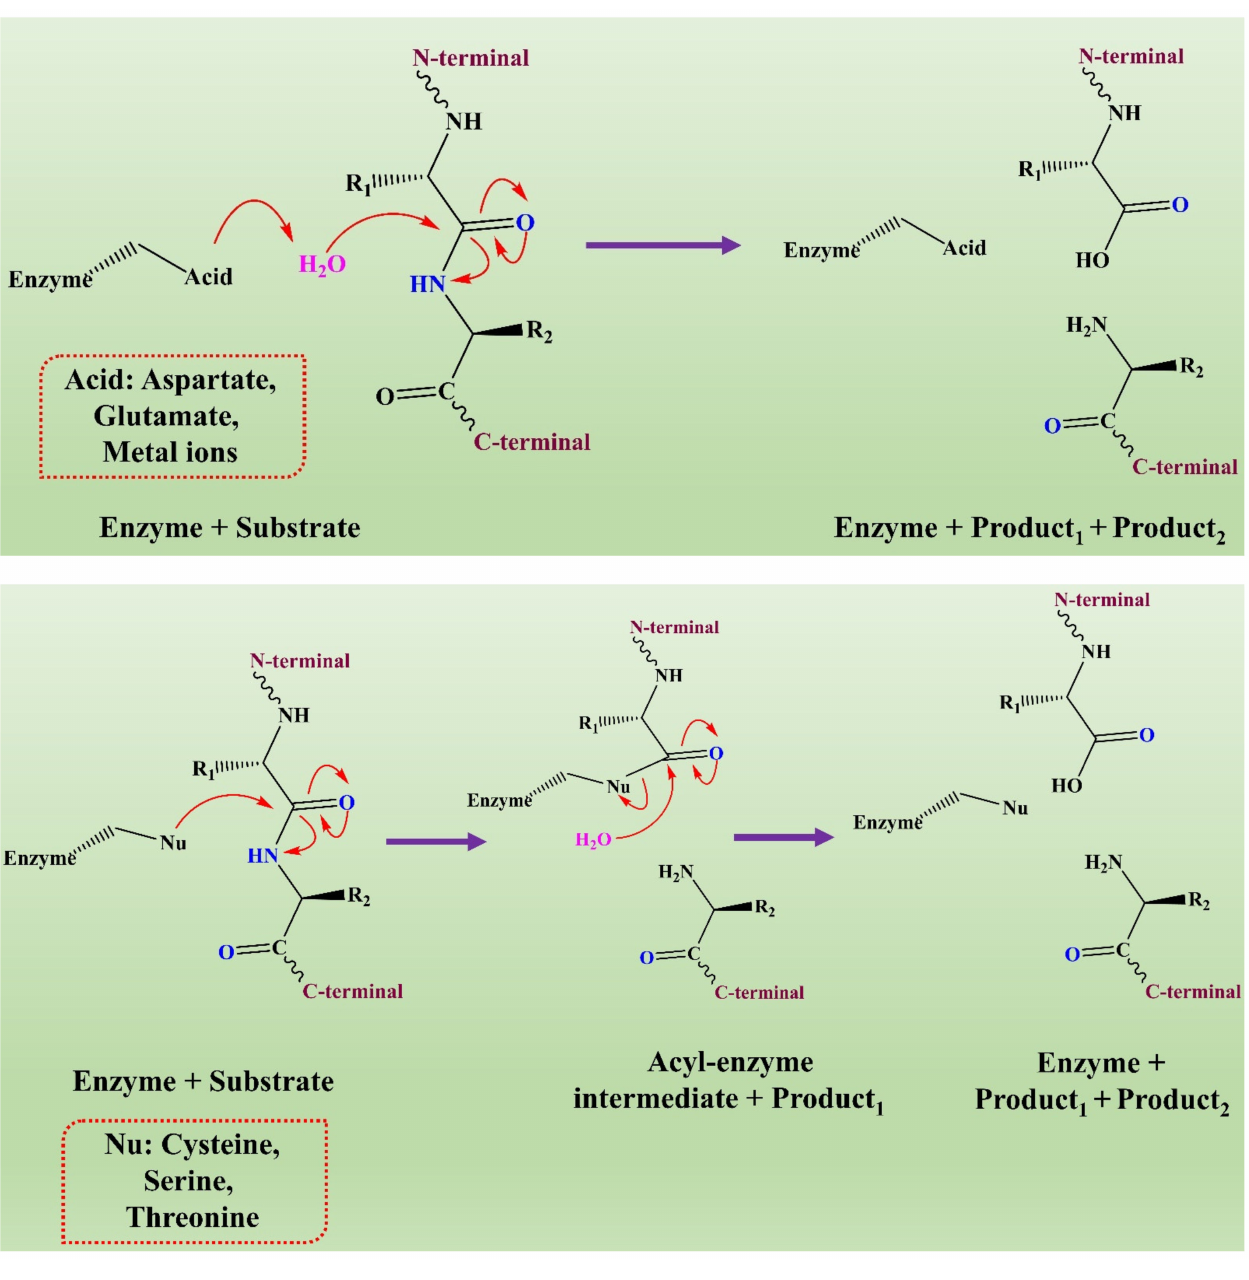
Figure 3. The representation of a comparison of the two hydrolytic mechanisms used for proteolysis. This figure is reproduced from Shafee [136] (Attribution NonCommercial 2.0 UK: England & Wales, CC BY-NY 2.0